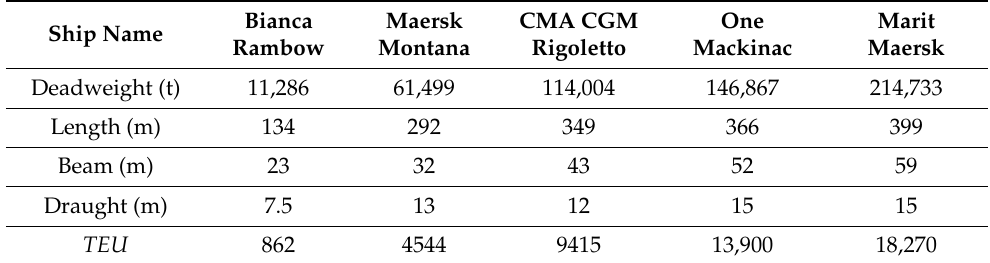
Table 1. Selected vessels and technical data [70].